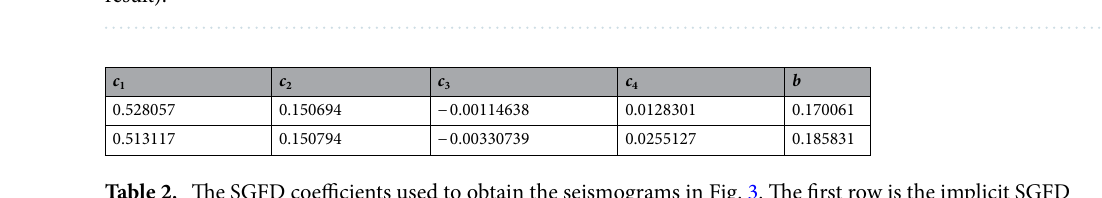
Figure 3. Accuracy comparison between the SGFD result and the analytical result. ( a ) The SGFD results overlapped with the analytical result; ( b ) 100 × (the difference between the SGFD results and the analytical result).